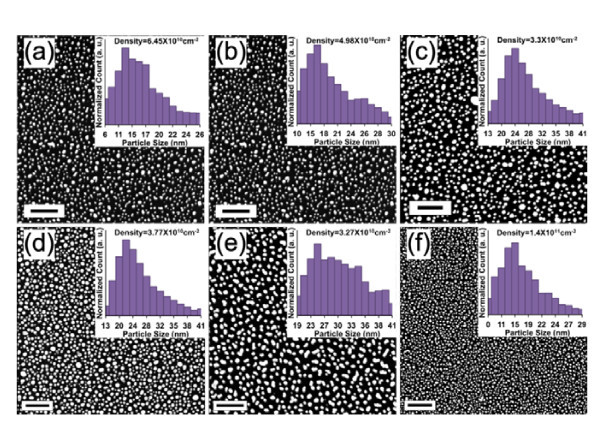
Scanning electron microscopy images and size distribution histograms. Scanning electron microscopy images and size distribution histograms of immersion time and pulse length dependent size distribution of AgNPs. From (a-e) the pulse length τ = 0.5 s with different immersion times: (a) t = 10 s, (b) t = 20 s, (c) t = 30 s, (d) t = 40 s, and (e) t = 50 s. (f) Pulse length τ = 1 ms and t = 50 s. Insets are histograms of the particle diameter. The scale bars in all Figures are 200 nm.